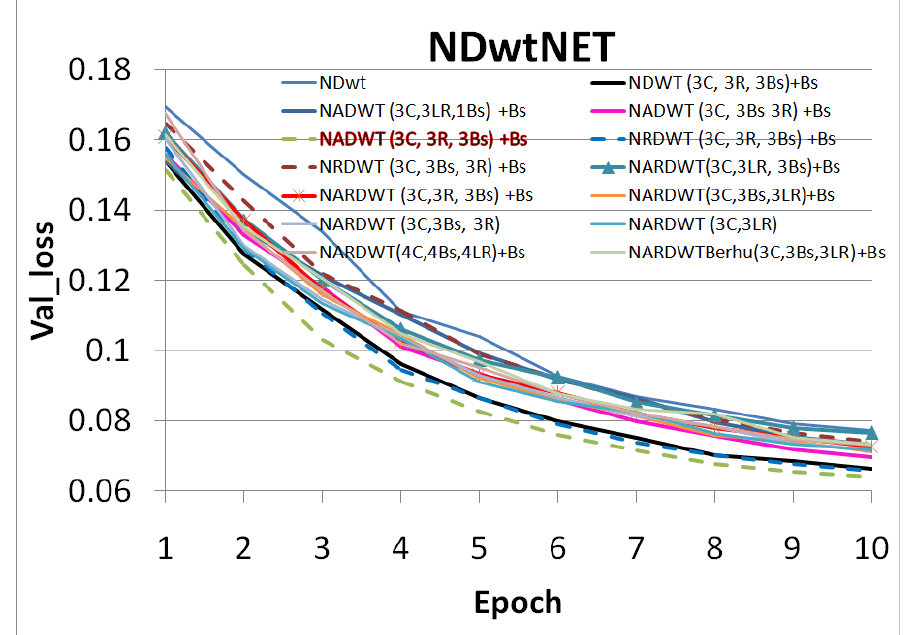
Figure 16. Model validation loss performance.